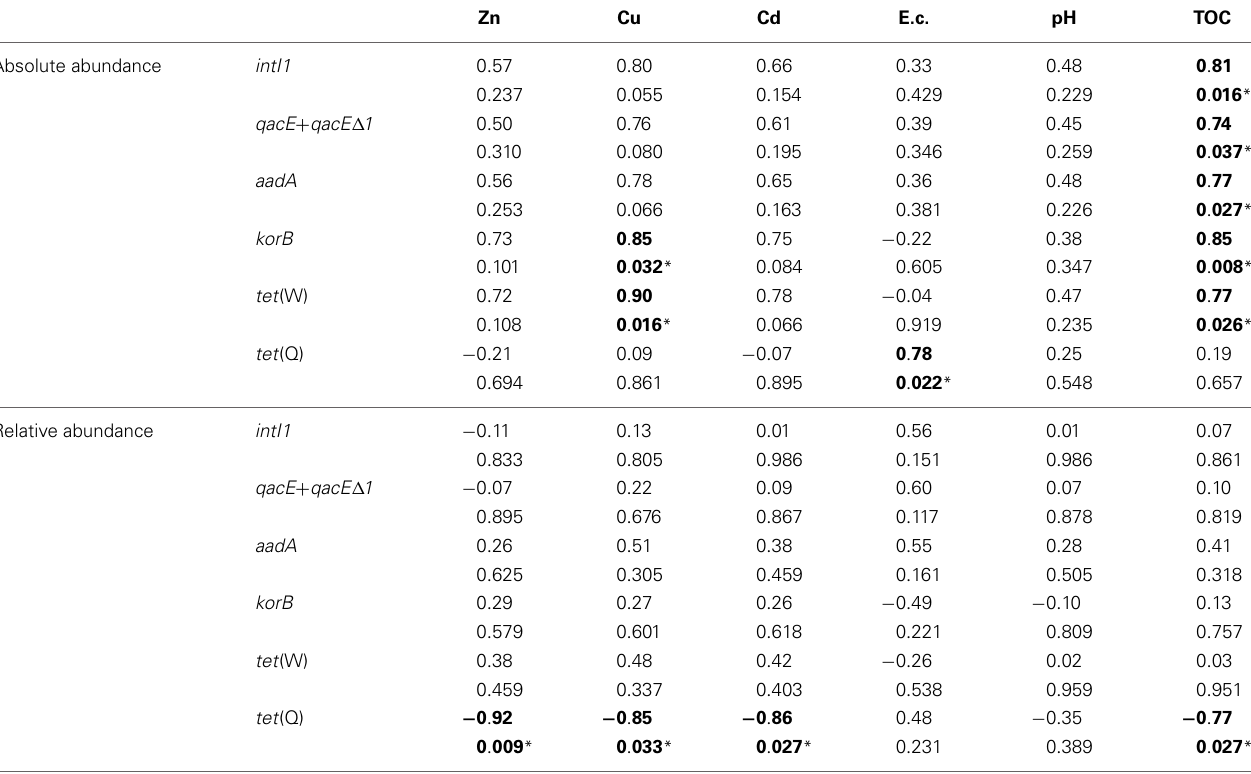
Table 4 | Correlation of absolute (log(gene copies/g soil)) and relative abundance (log(gene copies/ rrn copies)) of target genes with bioaccessible concentrations of heavy metals as well as with electrical conductivity (E.c.), pH and total organic carbon (TOC) (1.5–100 years of irrigation; Pearson correlation, p < 0 . 05; significance indicated in bold and by asterisk).